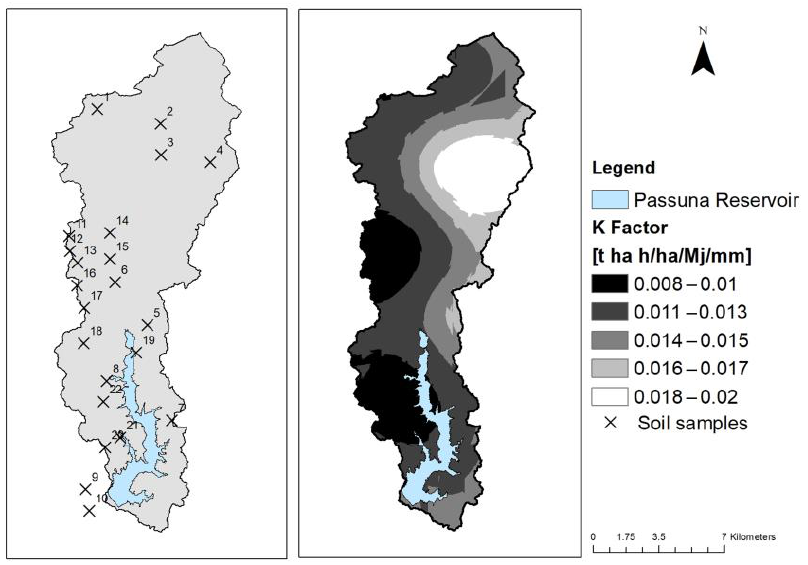
Figure 3. ( Left ) Location of soil samples; ( Right ) . Interpolated map of K Figure 13. ( a ) Location of soil samples; ( b ) . Interpolated map of K Factor.